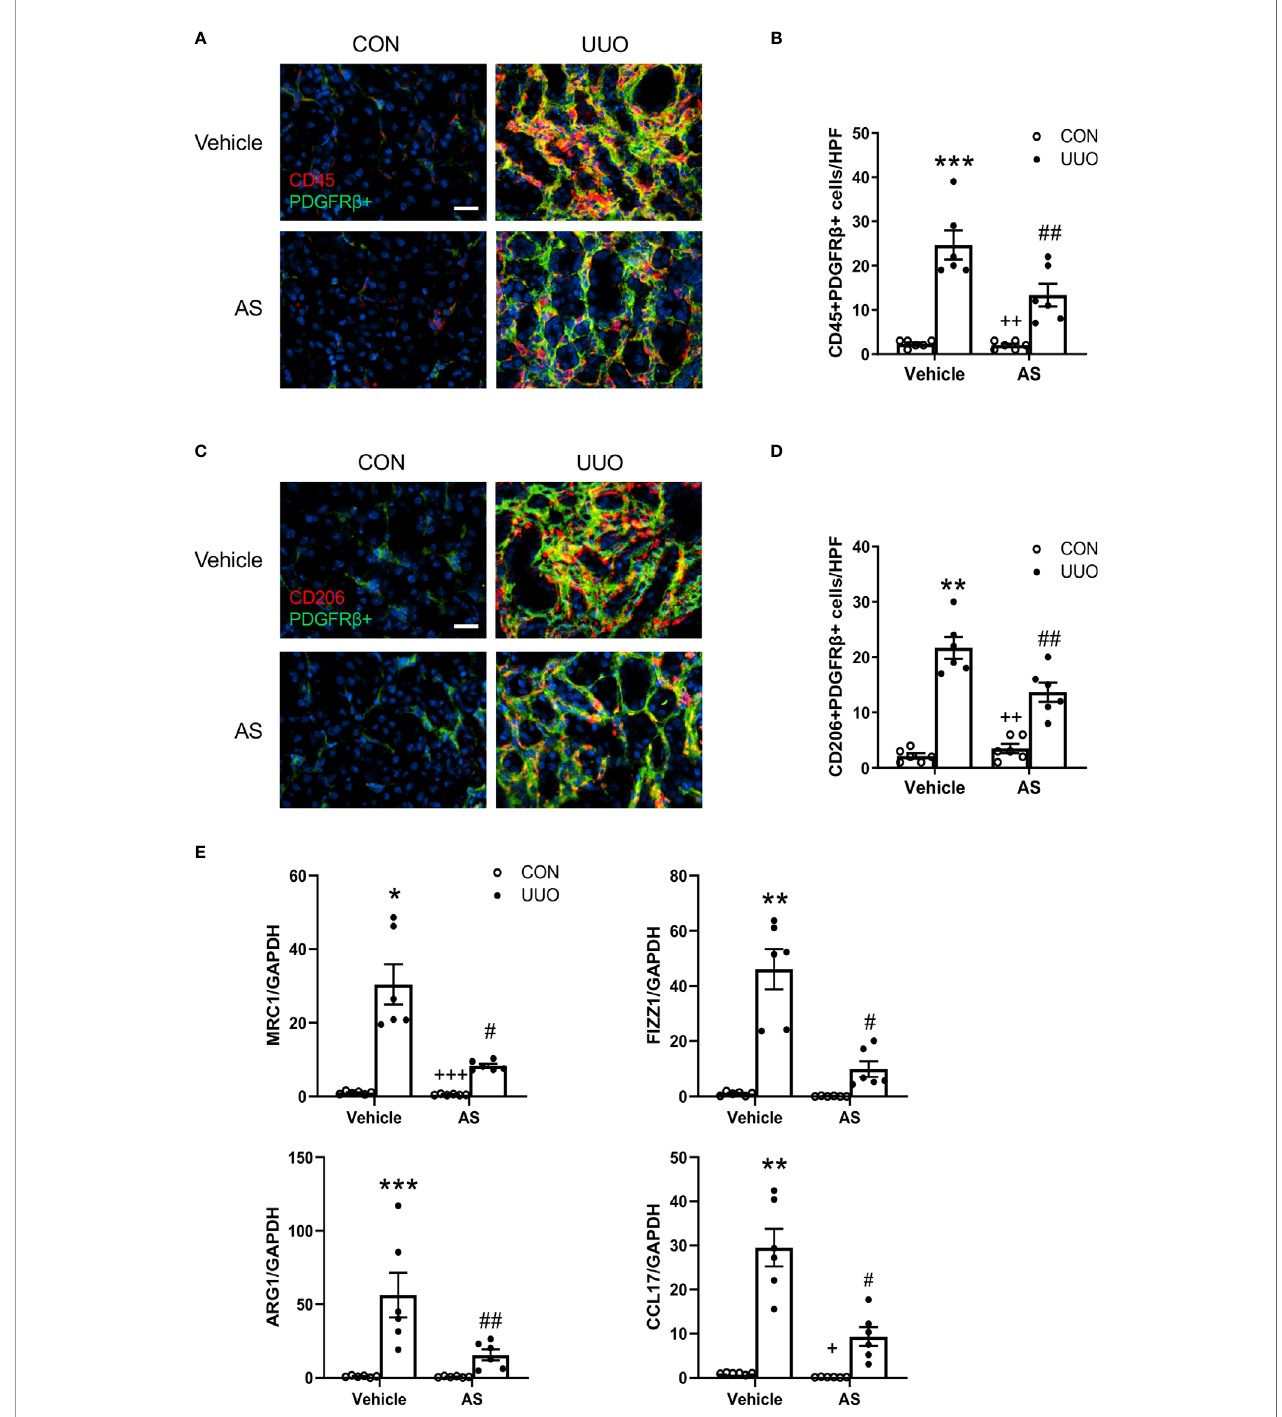
FIGURE 2 | AS1517499attenuatesmyeloid fi broblastaccumulationandmacrophagepolarizationinthekidneywithobstructiveinjury. (A) Representativephotomicrographsof kidneysectionsat day10ofUUOstainedfor CD45 (red),PDGFR- b (green),andDAPI(blue). Scalebar,50 m m. (B) QuantitativeanalysisofCD45 + andPDGFR- b + fi broblasts inthe kidney. *** P < 0.001 vs Vehicle-CON; ## P < 0.01 vs Vehicle-UUO; ++ P < 0.01 vs AS-UUO. n=6per group. (C) Representativephotomicrographsofthekidneyatday10ofUUO stainedfor CD206(red),PDGFR- b (green),andDAPI(blue). Scalebar,50 m m. (D) Quantitativeanalysis ofCD206 + andPDGFR- b + fi broblastsinthekidney.** P < 0.01 vs Vehicle- CON; ## P < 0.01 vs Vehicle-UUO; ++ P < 0.01 vs AS-UUO.n=6per group. (E) Quantitativeanalysis ofmRNAexpressionofM2macrophagemakers (MRC, FIZZ1, Arg1,CCL17 inthekidneyofVehicleor AS1517499treatedmice.*** P< 0.001, ** P < 0.01,* P < 0.05 vs Vehicle-CON; ## P< 0.01, # P < 0.05 vs Vehicle-UUO; +++ P< 0.001, + P< 0.05 vs AS-UUO. n=6per